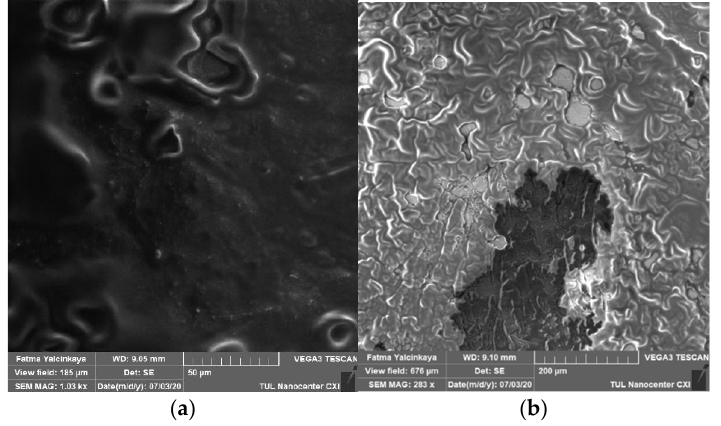
Figure 4. Top view of a membrane fouled by engine oil ( a ), and an image of the fouled membrane after the chemical cleaning process ( b ).